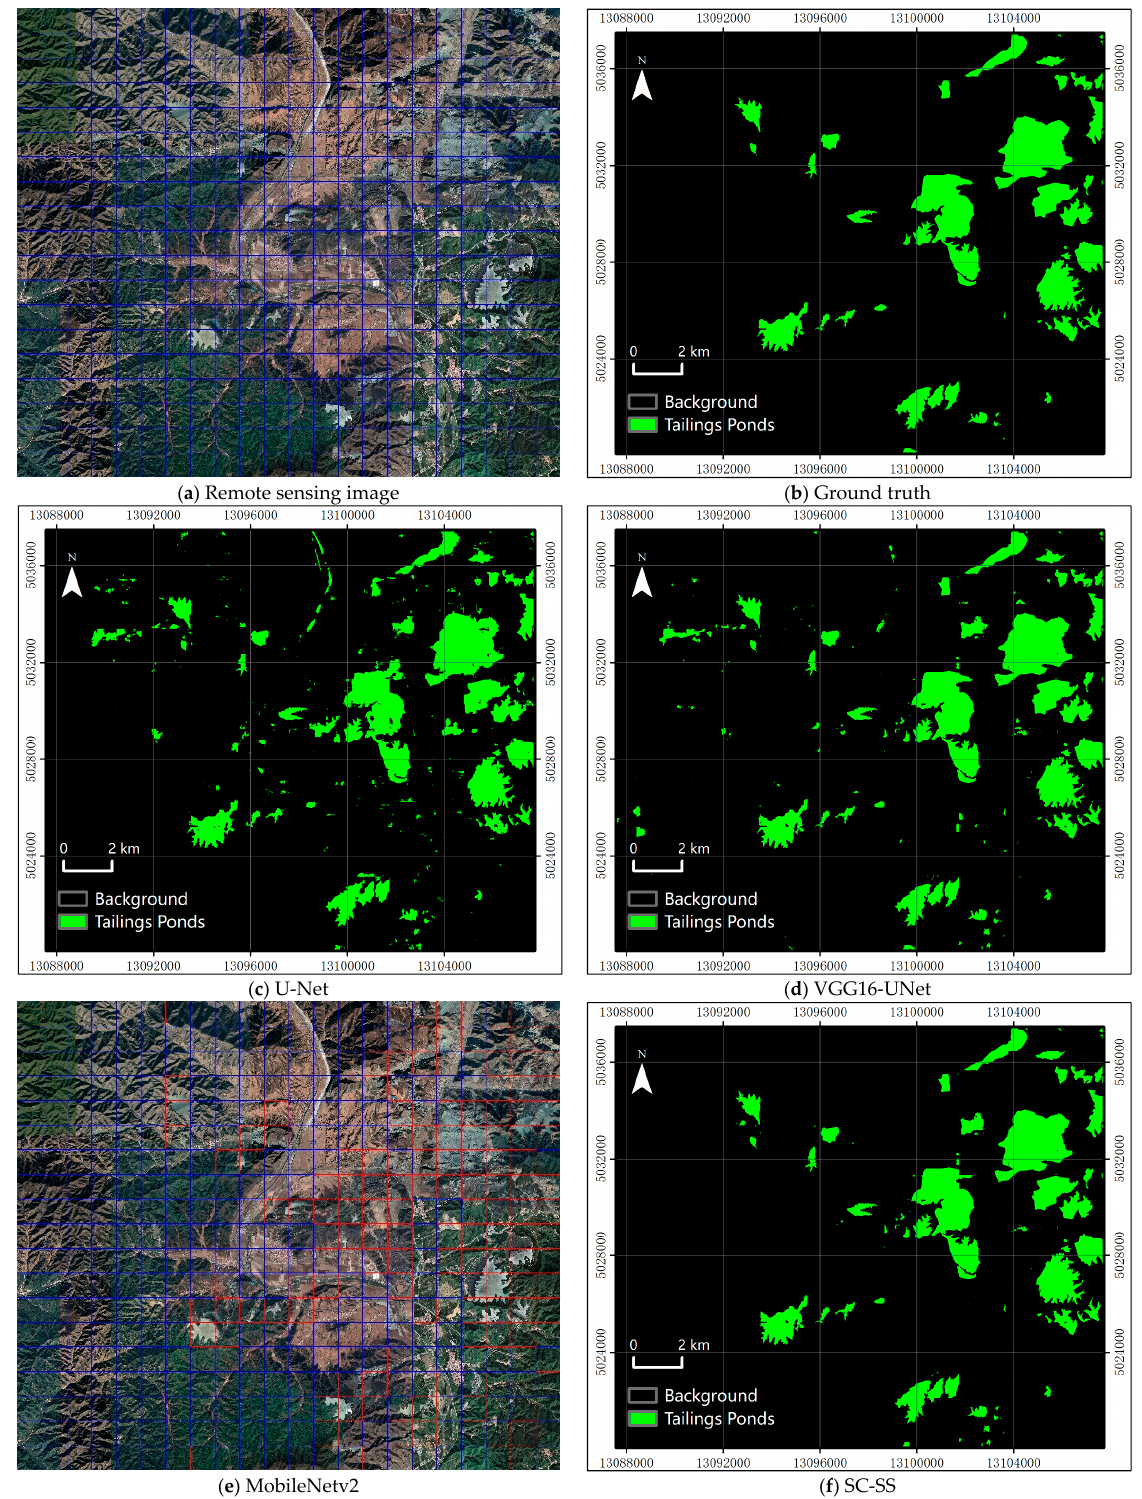
Figure 13. The comparison of various models’ visualization results on the large scene remote sensing image. ( a ) Large scene remote sensing image of tailings ponds; ( b ) corresponding ground truth; ( c ) U-Net model predictions for tailings ponds; ( d ) VGG16-UNet predictions for tailings ponds; ( e ) MobileNetv2 predictions for tailings ponds; ( f ) SC-SS model predictions for tailings